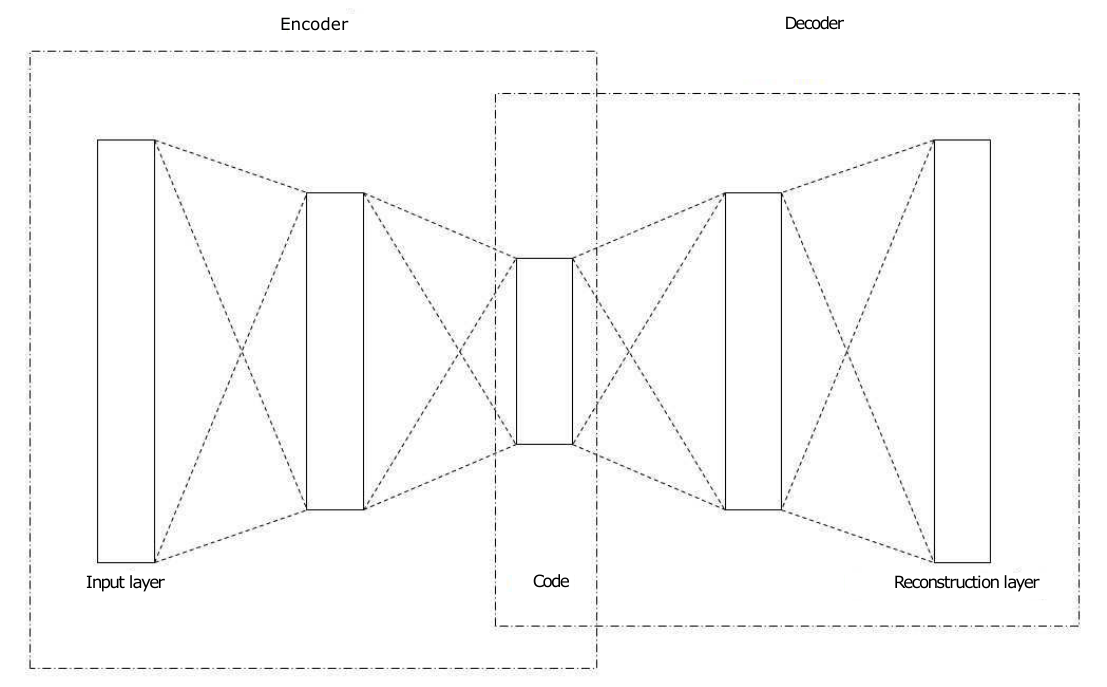
Figure 1. Typical structure of an